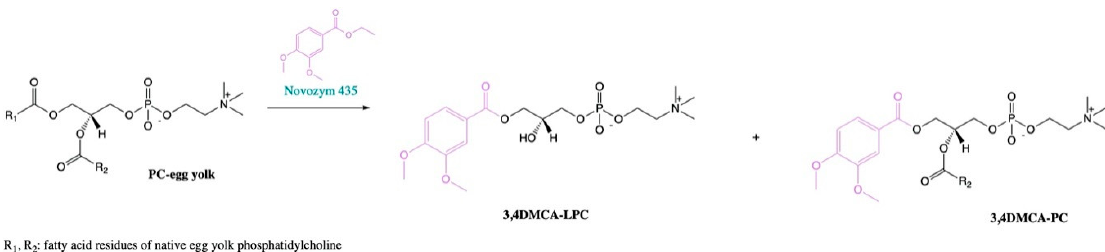
Figure 3. Reaction scheme of lipase-catalyzed interesterification of egg-yolk PC and